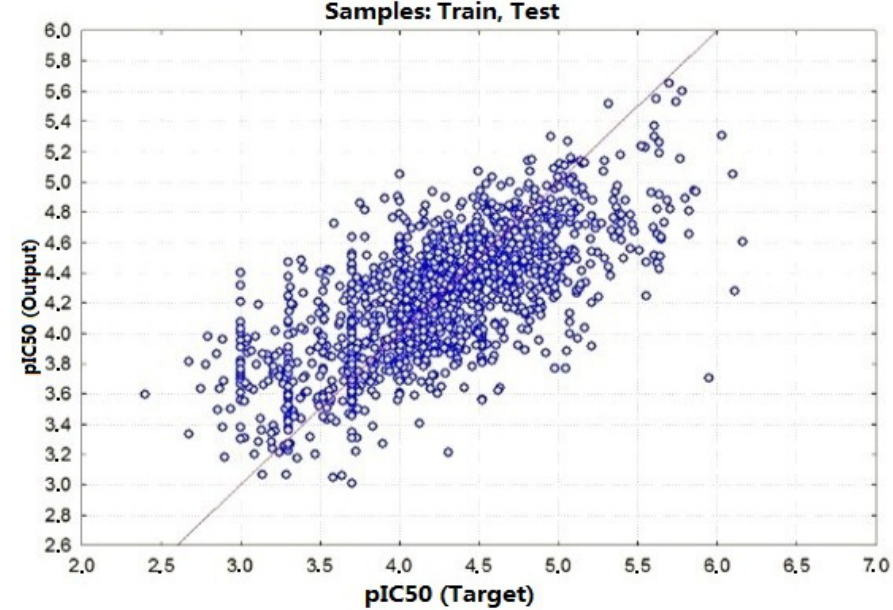
Figure 2. Correlation between experimental and predicted pIC 50.